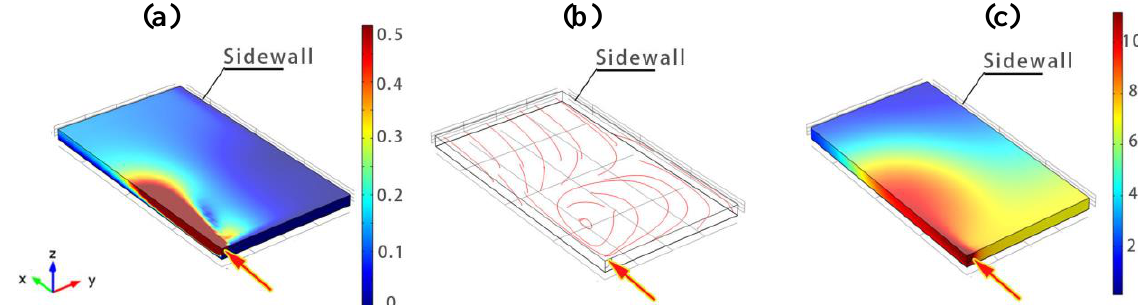
Figure 16. Velocity distribution ( a ), streamline of gas ( b ) and concentration of methane ( c ) of a box-type channel with a single inlet (F/w = 100,000 mL/g-cat/h, W = 2 cm).